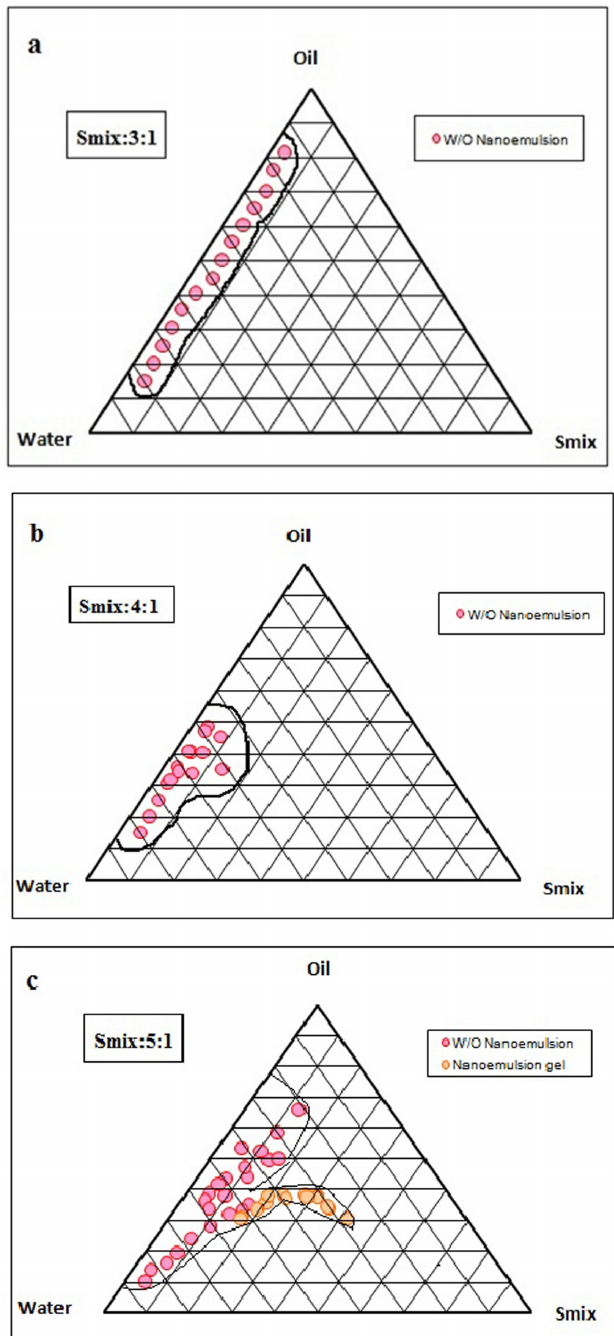
FIGURE 2- Pseudo-ternary phase diagrams indicating water-in- oil nanoemulsion region at different Smix (S:Cos)